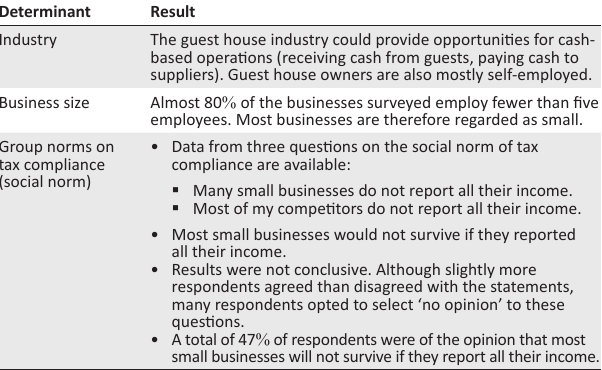
TABLE 5: Results of the analysis for the population surveyed using the factor ‘Specific tax situation’.